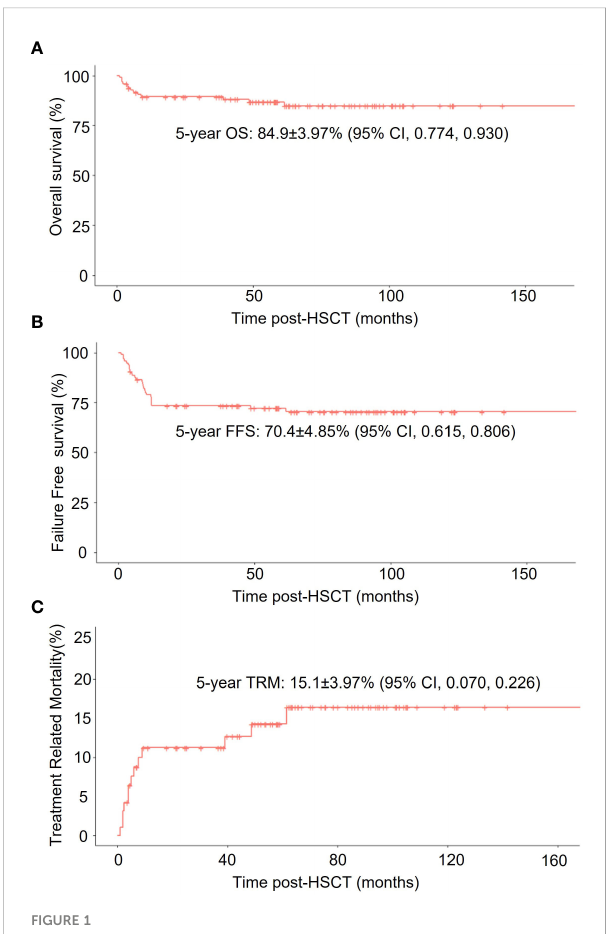
FIGURE 1 Survival analysis of all enrolled HAAA patients. (A) Overall survival (OS); (B) Failure-free-survival (FFS); (C) non-relapse mortality (TRM) in all patients.